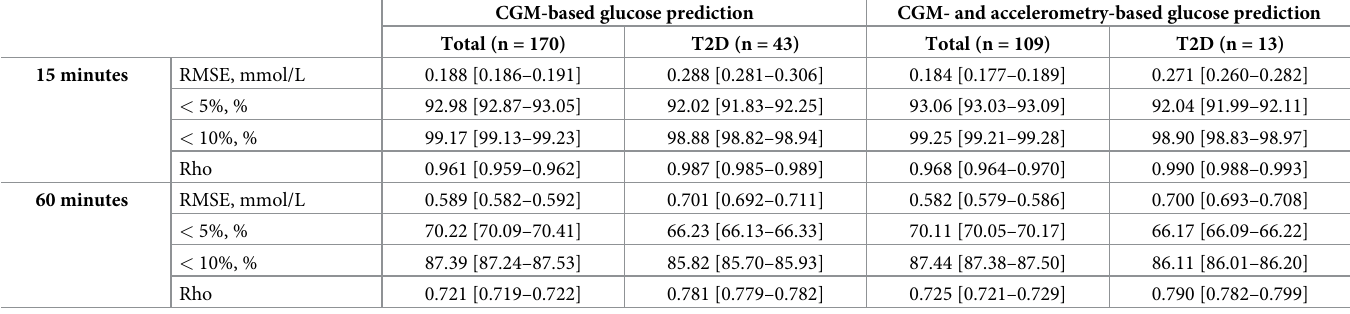
Table 3. Overall performance in the main study population of CGM-based and CGM- and accelerometry-based machine learning models trained in predicting glu- cose values at time intervals of 15 and 60